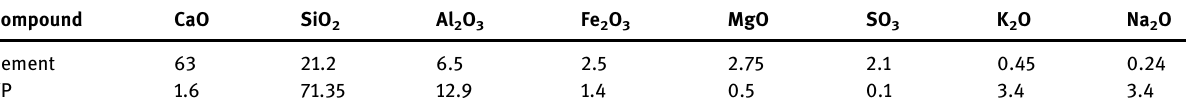
Table 2: Chemical composition of